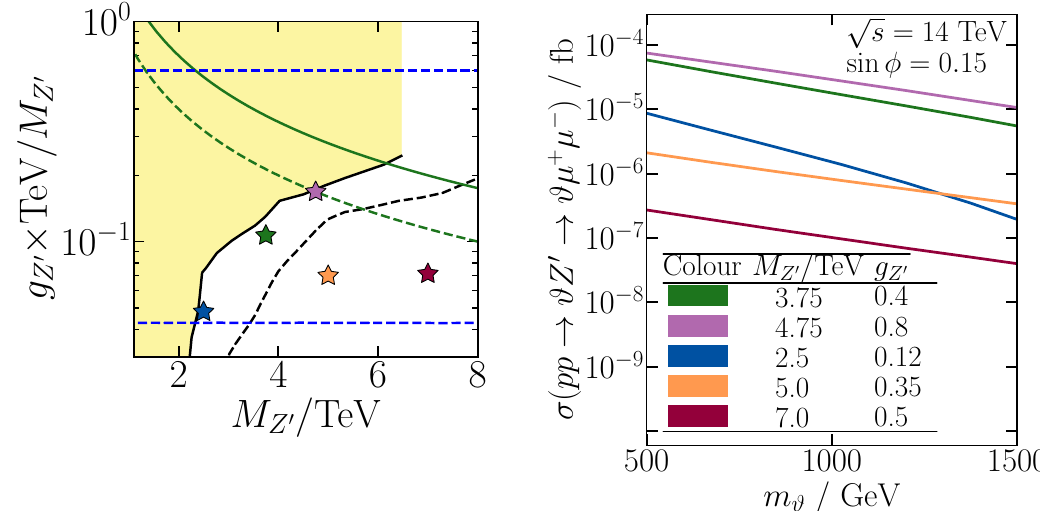
Figure 10. The left-hand panel, based on figure 9 of ref. [21], shows the g Z 0 − M Z 0 plane of the parameter space. Everything above the solid black line is excluded at the 95% CL by the LHC whereas the dashed black line indicates the projected 95% CL sensitivity of the HL-LHC. The dashed and solid green lines indicate the Γ /M Z 0 = 1 / 3 and Γ /M Z 0 = 1 bounds, above which perturbative computations become inaccurate. The region between the blue dashed lines is the region allowed by the fits discussed in section 3.1. Were another fit including the new R K and R K ∗ measurements [16, 17] to be performed, the position of the lower blue line would be revised downward. Coloured stars have been superposed on the figure, with each star labelling a benchmark point in the parameter plane. The right-hand panel shows tree-level flavonstrahlung cross-sections for 14 TeV pp collisions with the flavon charge q θ set to unity. Each coloured line corresponds to a parameter space point labelled by a star of the same